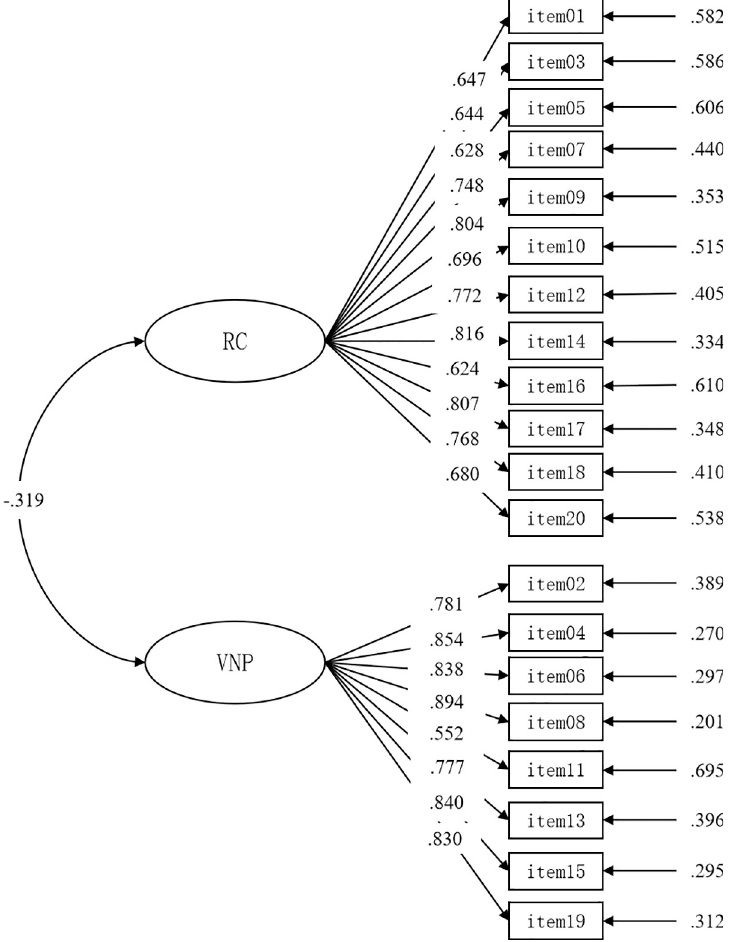
Fig 1. Confirmatory factor analysis results of the Chinese version of CREST. RC = resilient characteristics; VNP = vulnerabilities under pressure.